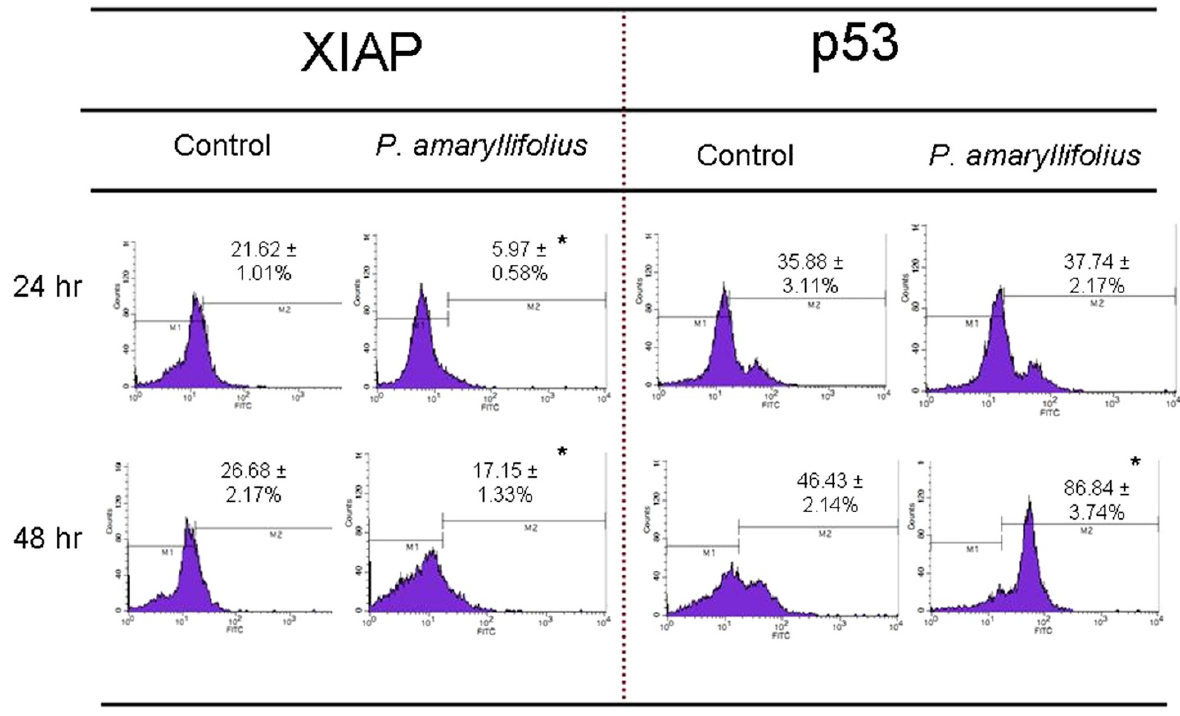
Figure 3 P. amaryllifolius extract induced the population of MDA-MB-231 cell that expressed tumour suppressor p53 protein while downregulated the population that expressed apoptosis inhibitor protein XIAP as compared to control cells. Values are presented as means (n=3)±S.E. *signified